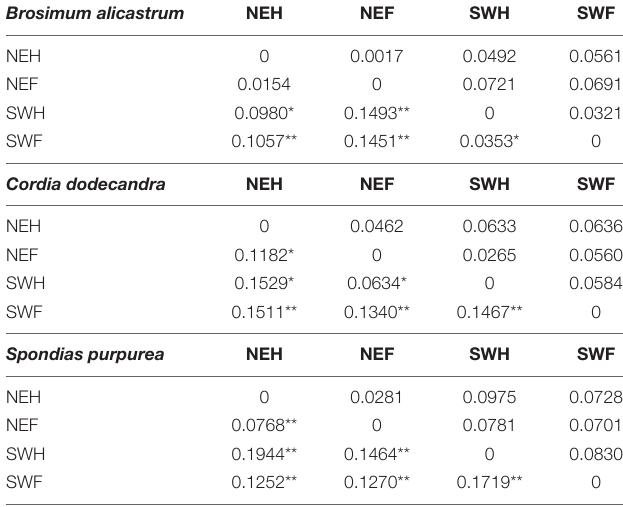
TABLE 5 | Pairwise F ST and (cid:56) ST values (upper and lower diagonal, respectively) between populations of Northeast (NE) and Southwest (SW) regions of Yucatan, Mexico, and from two population types forest and homegardens (F and H, respectively) of three multipurpose trees. Brosimum alicastrum